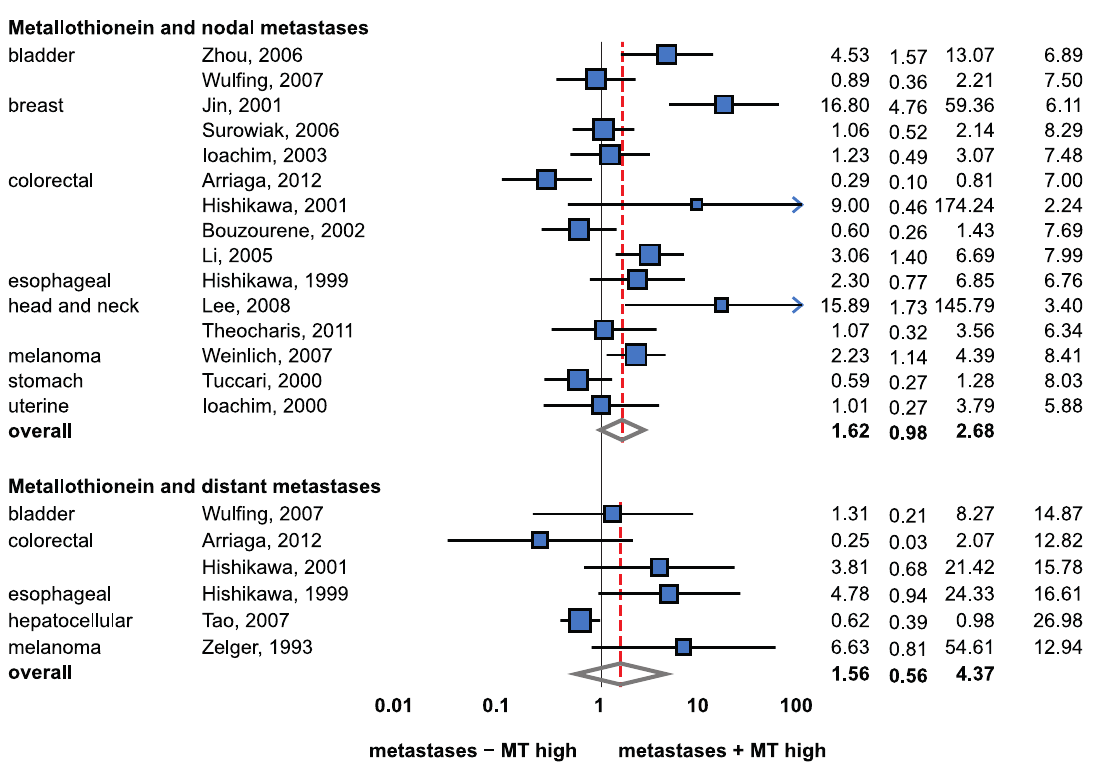
Figure 5. Forrest plot of studies reporting the association of metallothionein staining and nodal and distant metastases. Random effects model used for both outcomes, Relative weight of individual studies displayed in %. For more detailed results see Table 1 and 2. Sorted alphabetically by tumor types. Forrest plot displayed as odds ratio and 95% confidence intervals. Red dashed line indicates the result for all studies together. OR, odds ratio; CI, confidence